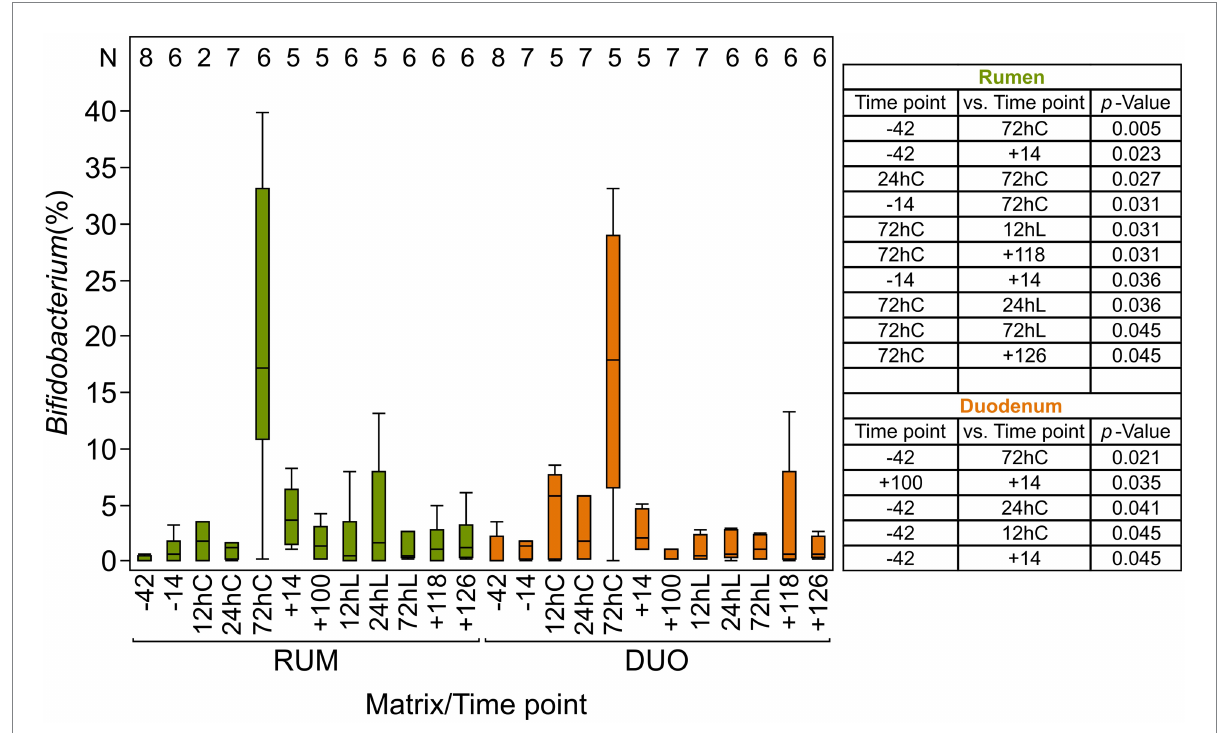
FIGURE 4 Relative abundance (%) of Bifidobacterium in rumen and duodenal fluid samples The table includes significantly different time points ( p ≤ 0.05) among rumen and duodenal fluid samples, calculated using non-parametric Wilcoxon test. Time points including a “–” or “+” indicate days antepartum or postpartum and time points including “hC” or “hL” are samples taken at 12, 24, or 72 h after calving or LPS challenge, respectively. N -Values refer to total samples included per time